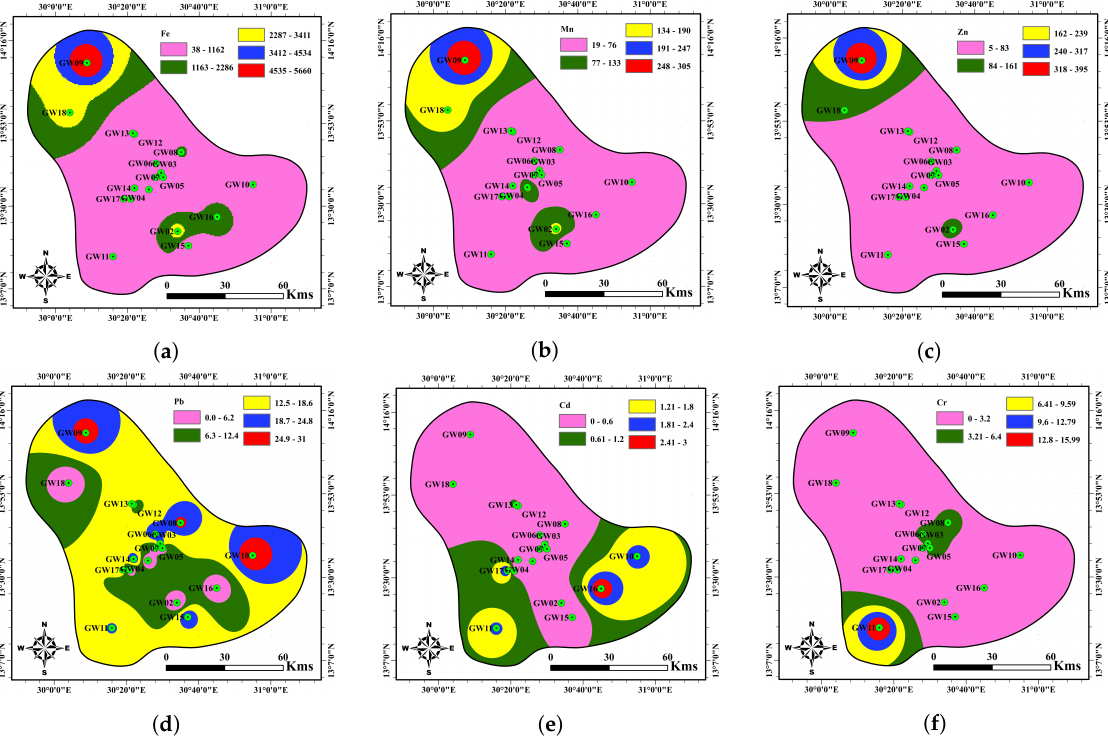
Figure 2. Spatial distribution of heavy metal ions in the groundwater samples and GIS interpolation maps of ( a ) Fe, ( b ) Mn, ( c ) Zn, ( d ) Pb, ( e ) Cd and ( f ) Cr in the study